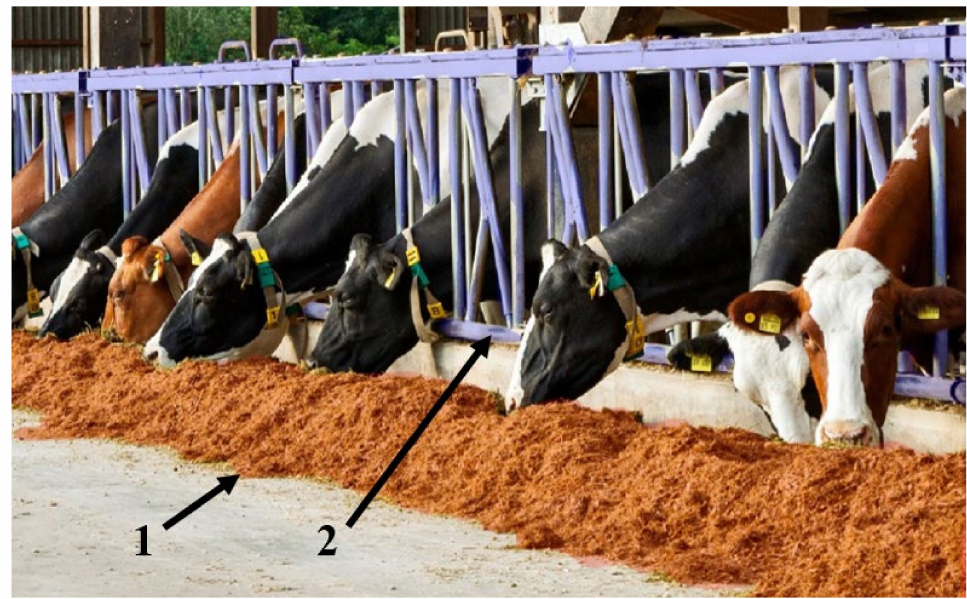
Figure 1. Preliminary semantic segmentation Images: 1-feed, 2- frame of milking cows’ stall.